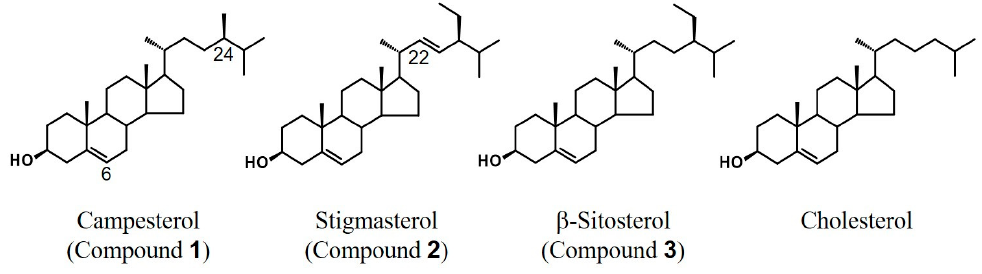
Figure 3. Structures of purified compounds and cholesterol.